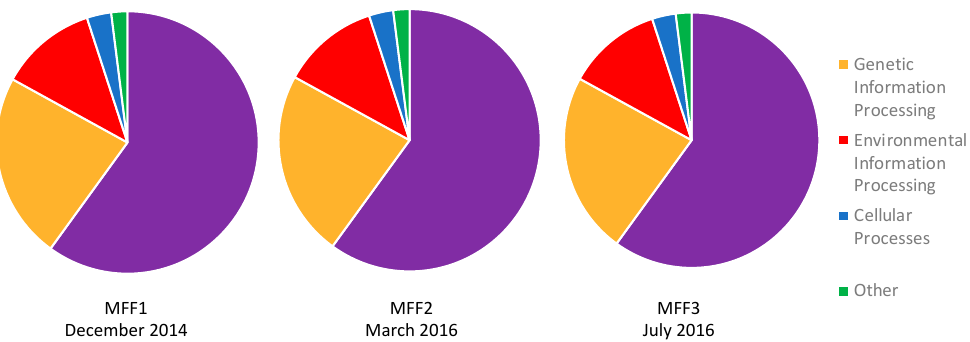
Figure 3. KEGG Orthology (KO) of functional genes obtained from samples MFF1, MFF2, and MFF3. Genes related to metabolism dominate in about 60% of the sequences in all three samples, followed by genetic information processing (23%), environmental information processing (12%), and cellular processes (3%). Other funtions are less than 1%. Samples were named MFF1 for the first sampling, MFF2 for the second sampling, and MFF3 for the third sampling (MFF stands for “Muestra Final Fraternidad” which means Fraternidad Final Sample). Figure 3 details the predicted protein sequences of each metagenome into functional categories, according to the KEGG orthology database. Around 60% of the contigs obtained in all three samples were related to metabolism. This is consistent with other results in hypersaline environments, where